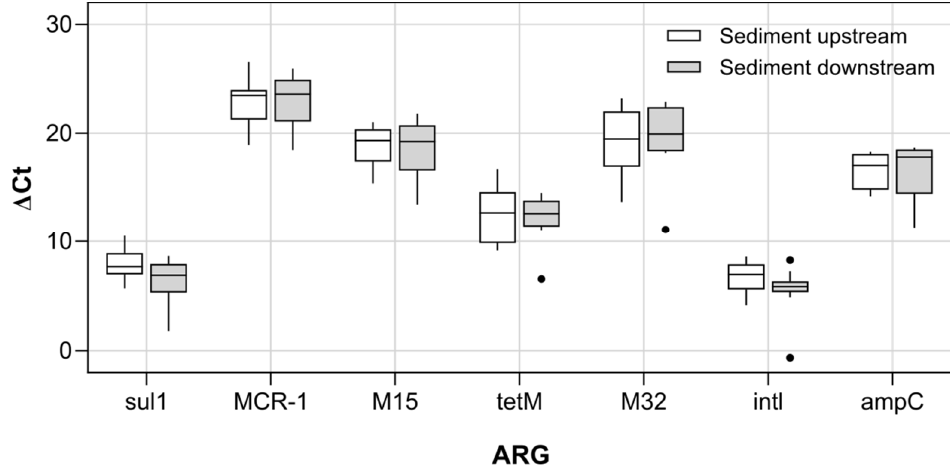
Figure 11. Normalized expression levels of ARGs in the sediment samples taken upstream and downstream of the WWTP. ● indicate data points located outside whiskers of the Tukey's boxplot (outliers)